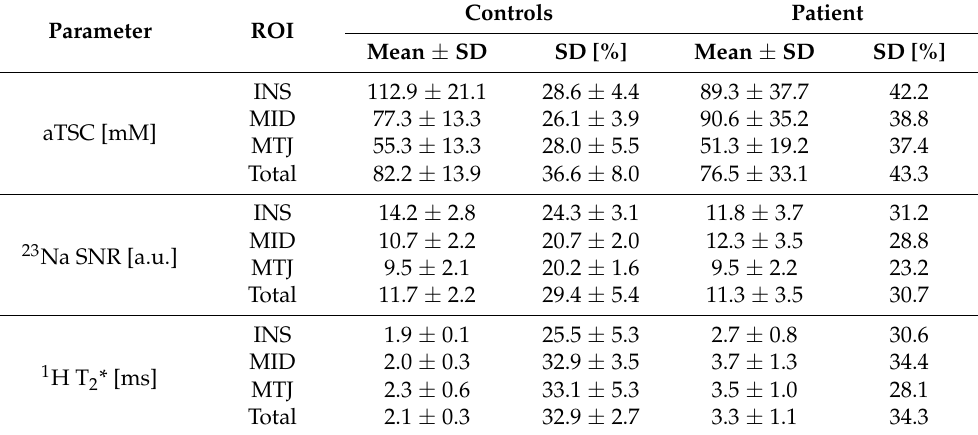
Abbreviations: SD—Standard deviation of relaxation times within a region, aTSC—apparent tissue sodium concentration, SNR—signal-to-noise ratio.